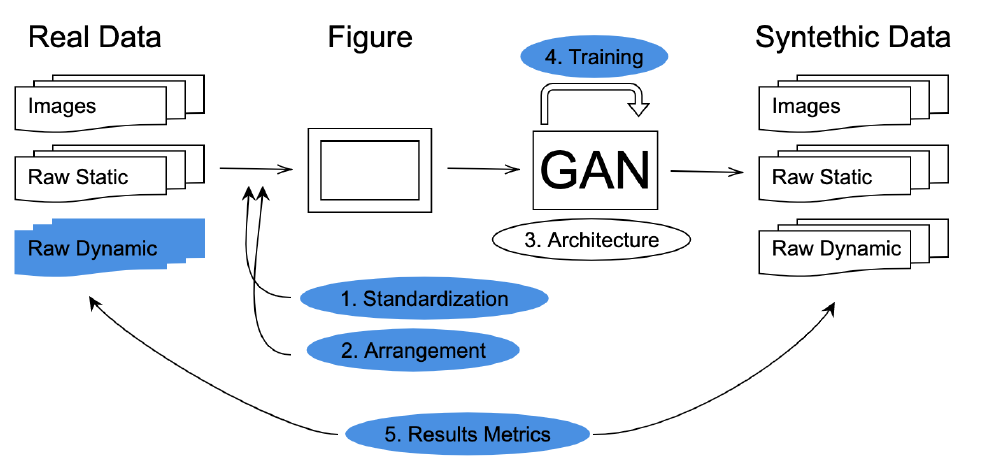
Figure 1. Diagram with the proposed procedure and the working